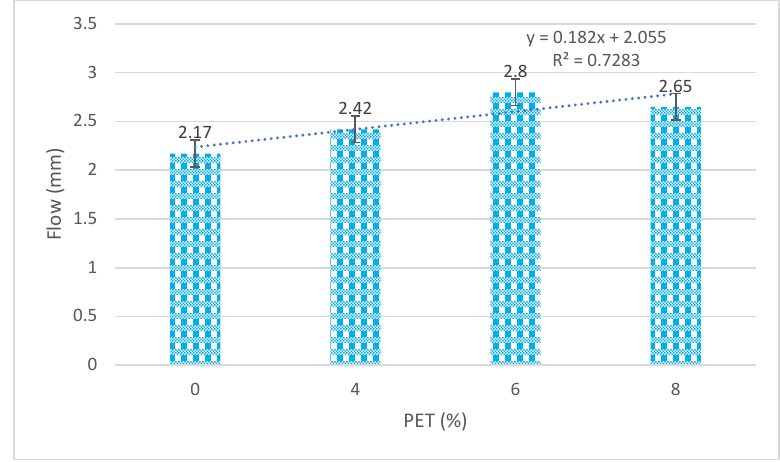
Figure 8. Flow of the PET-modified SMA asphalt mixtures. Recycling 2022 , 7 , x FOR PEER REVIEW